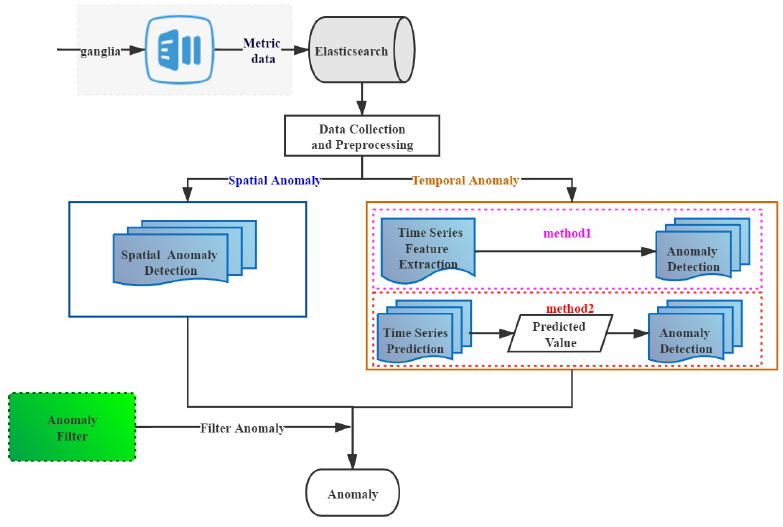
Figure 1. Anomaly detection